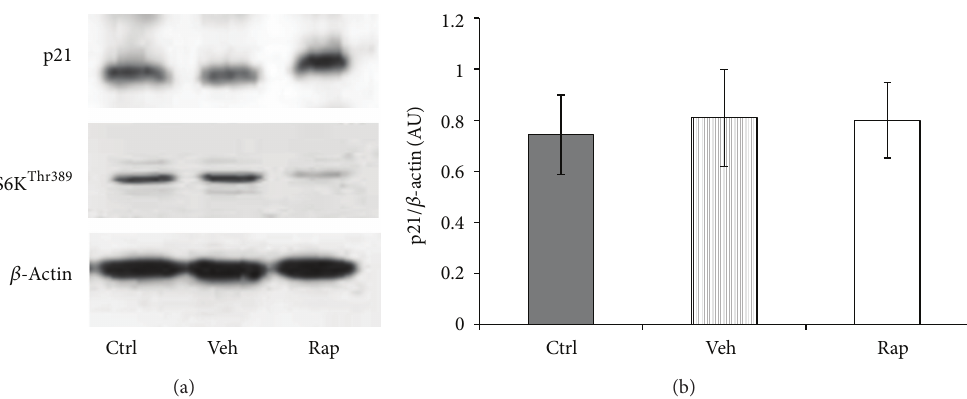
Figure 8: mTOR inhibition by rapamycin does not have a negative effect on p21 regulation. HEK293 cells were incubated with 100nM rapamycin (Rap) for 24 h. Vehicle effects were controlled by 0.1% ethanol treatments. (a) Representative western blot image of p21 and 𝛽 - actin expression. (b) Band intensity was quantified by densitometry. Data are arbitrary units (AU) expressed as means ± SEM ( 𝑛 = 6 ).